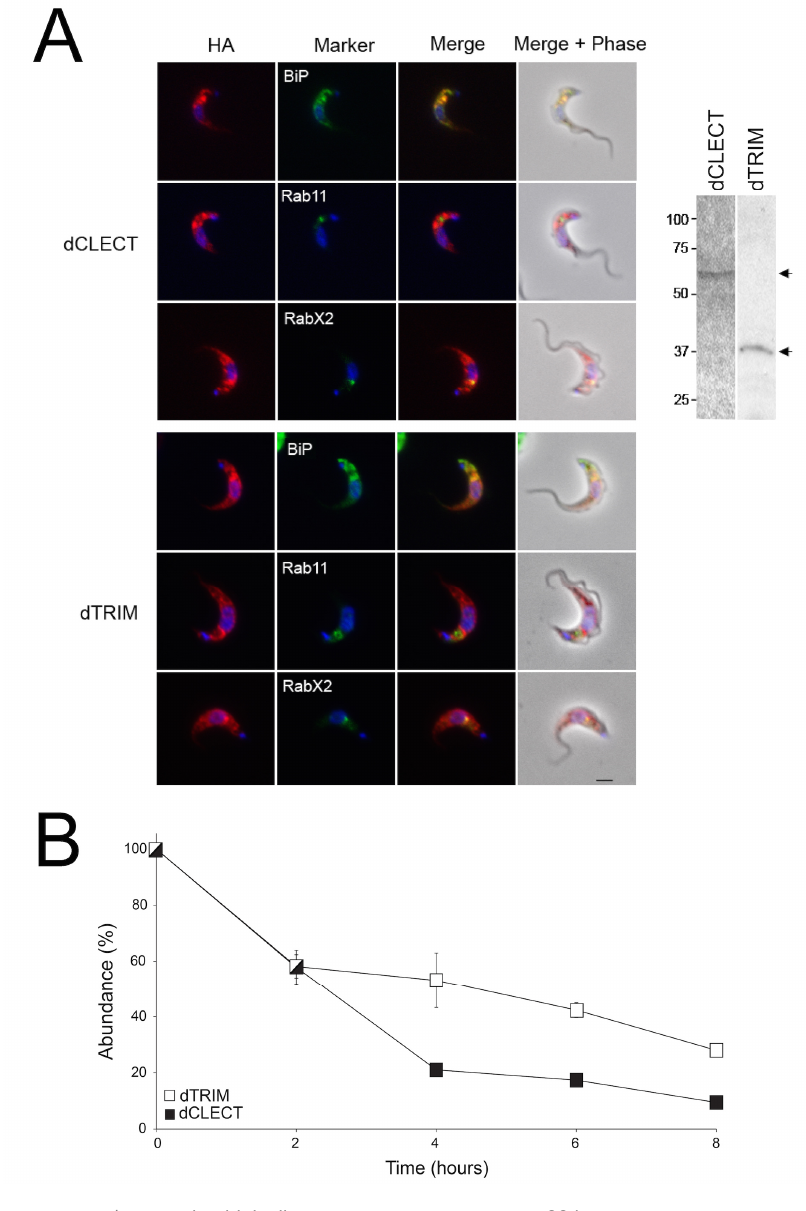
FIGURE 6: Subcellular localisation of BiPN- IGP48 chimeras is not dependent on the lumenal domain. (A) The IGP48 CLEC (dCLEC) or trimerisation lumenal domain (dTRIM) was replaced with the BiP ATPase domain and the location determined by immunofluorescence. In each case the BiPN chimera is in red and a marker protein visualised using polyclonal antibodies is in green. Scale bar = 1 μm. Verification of protein expression was carried out by Western blot (inset at right). Due to low expression, blots have been deliberately overexposed and relevant reactivity is indicated with arrows. (B) Turnover of dCLEC and dTRIM constructs. Protein deg- radation following cycloheximide treat- ment was monitored as described in Figure 2. Experiments were done in duplicate and error bars indicate standard error of the